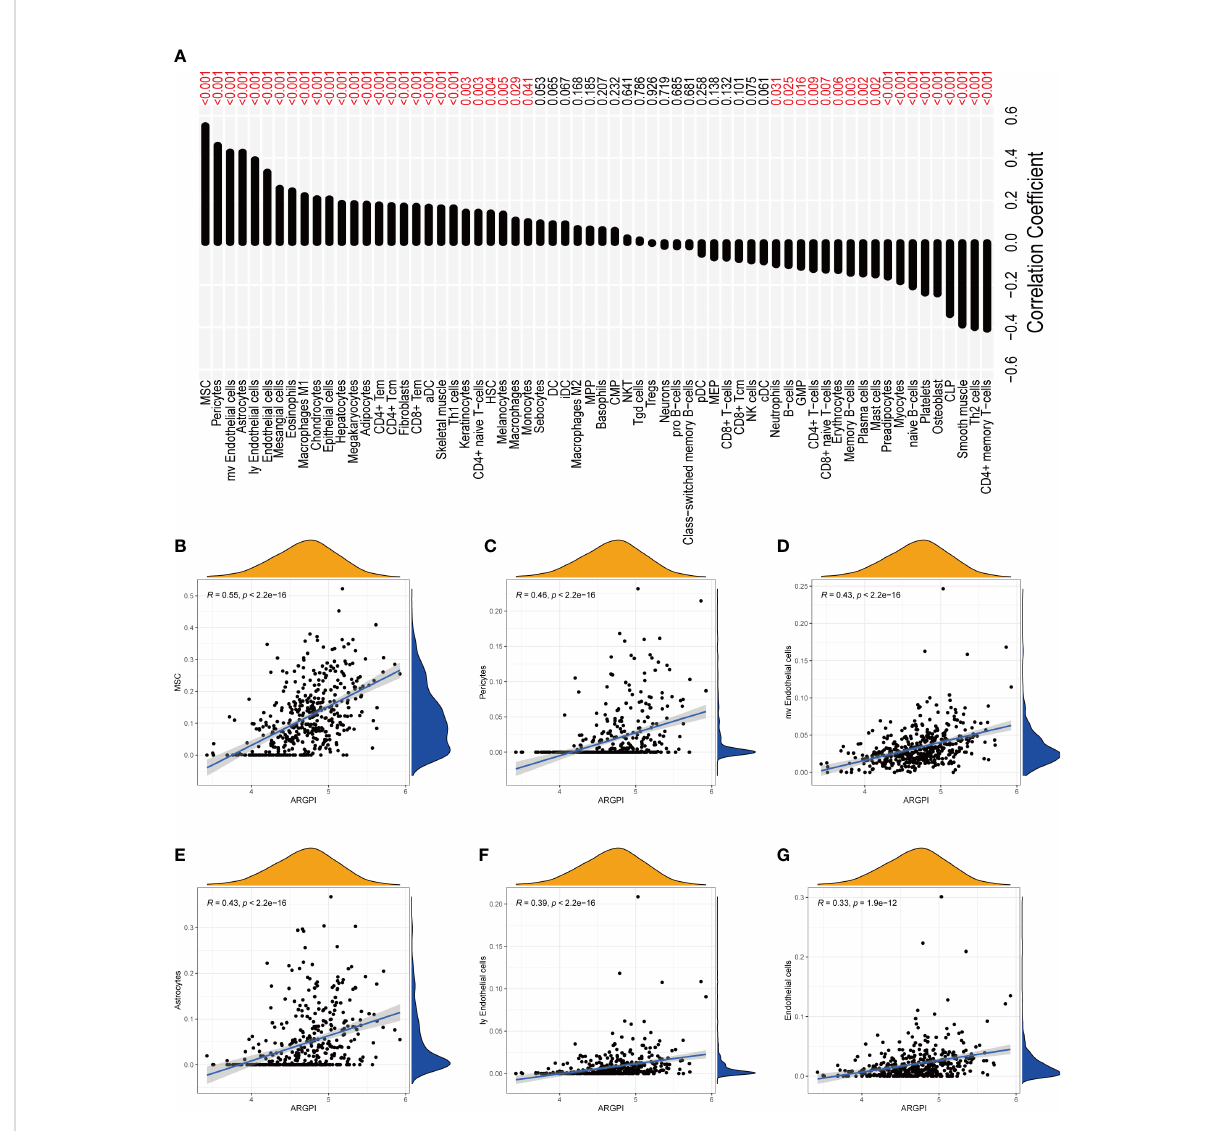
FIGURE 5 Correlation between ARGPI and immune cell in fi ltration. (A) Correlation histogram of ARGPI with 64 kinds of immune cells and stromal cells. (B – G) Scatter plot of 6 immune cell correlations most signi fi cantly associated with